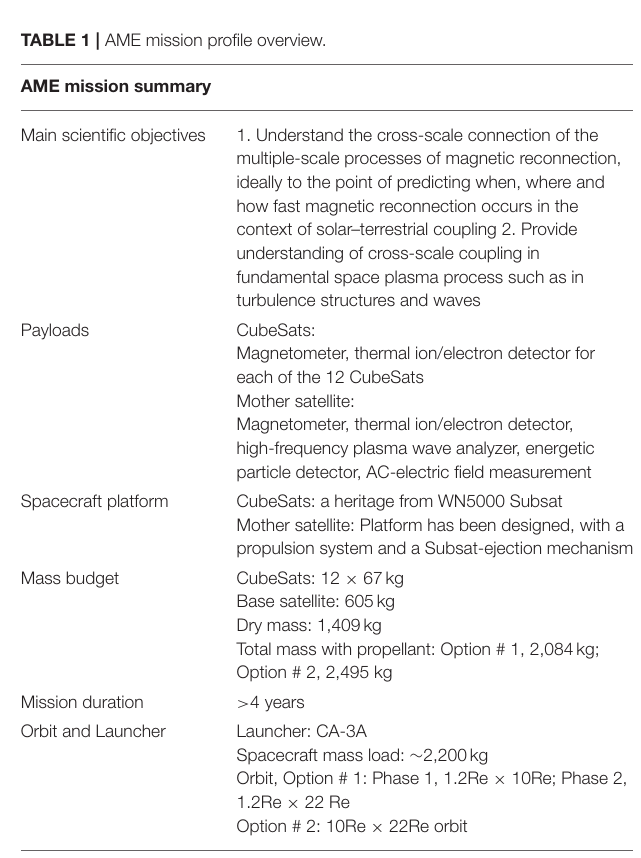
FIGURE 2 | Schematic showing the spatial scales of past magnetosphere constellation missions and proposals since year 2000.